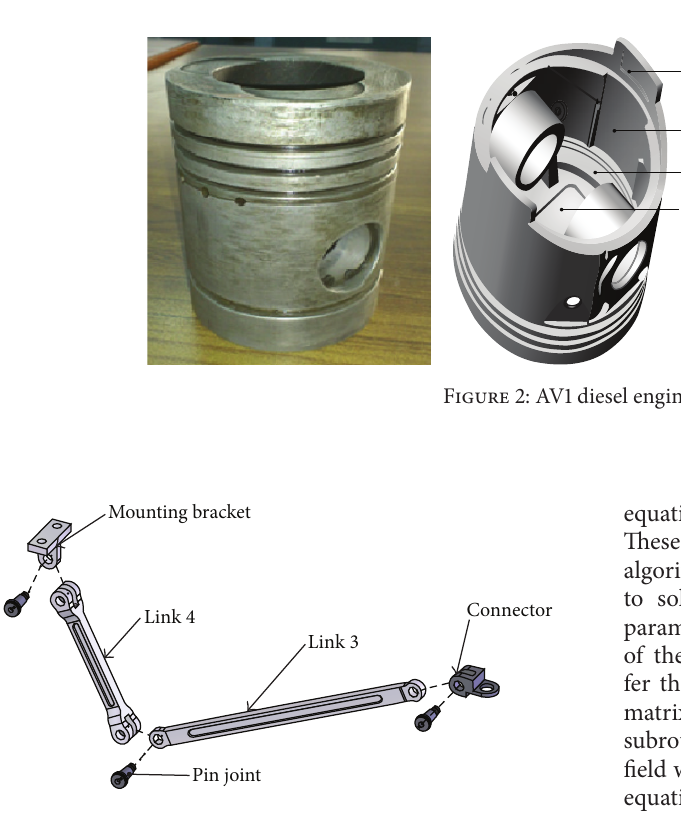
Figure 3: Four-bar